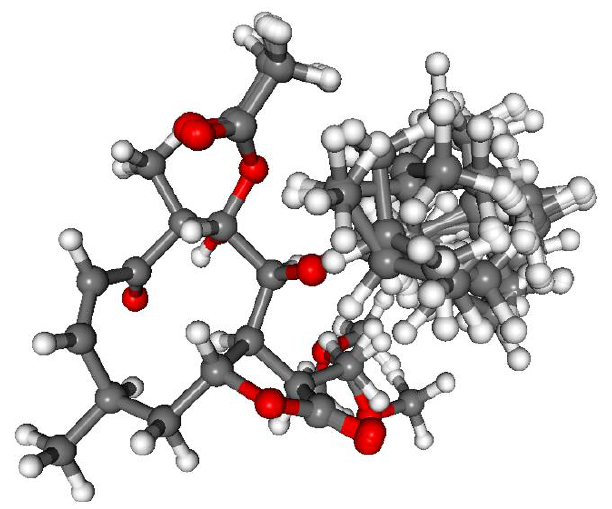
Figure 10. Overlapped geometries of the twelve low-energy CAM-B3LYP/TZVP PCM/MeCN conformers of (4 R ,6 R ,7 S ,8 S ,9 R ,10 R ,11 S )- 5 .